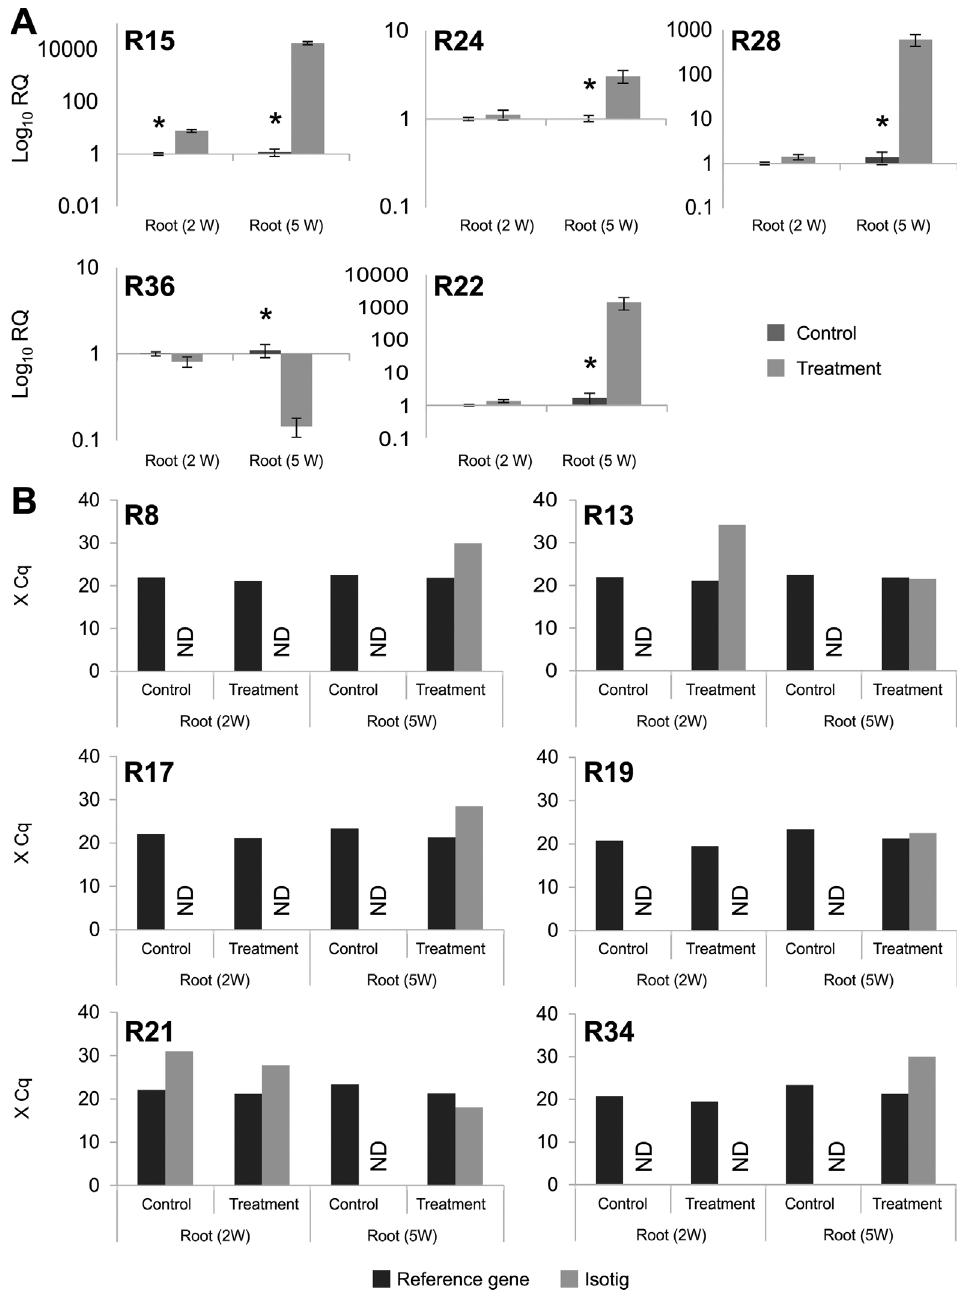
Figure 2 - RT-qPCR analysis of selected root transcripts. Expression is shown for 11 transcripts that were validated by RT-qPCR. Wheat roots were sam- pled from two-week-old (2 W) plants, where control plants were irrigated at 100% of field capacity (FC) and treated plants were irrigated at 75% FC. Five-week-old (5 W) plants are represented by control plants (irrigated at 100% FC) and treated plants, where irrigation was withdrawn for three weeks. The experiment was performed in triplicate biological samples and in technical triplicates. (A) Relative expression was calculated by the 2 - (cid:4)(cid:4) ct method. Asterisks represent significantly different (Student’s t- test, p (cid:5) 0.05) transcript levels. (B) Mean of the Cq value. “ND” means not detected. For more de- tails on primers see Table 2 and Table